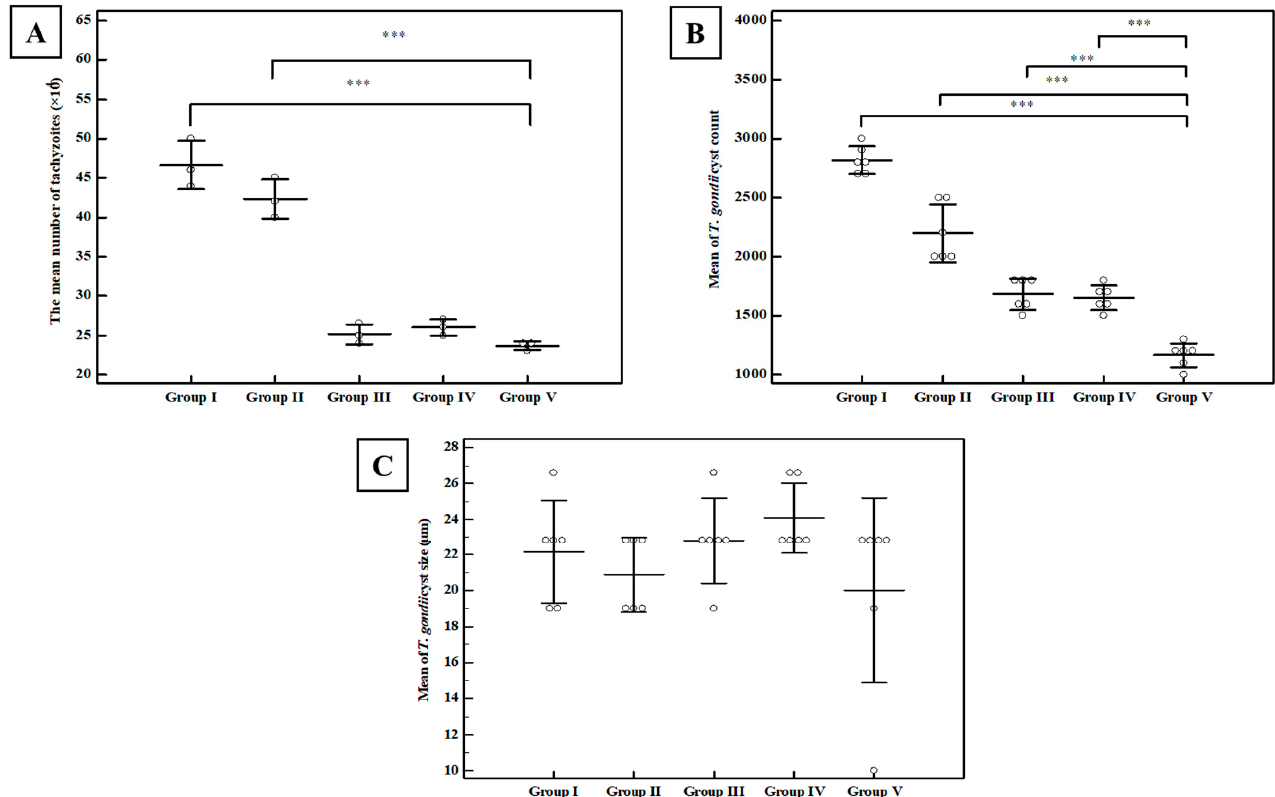
Figure 6. Parasitological study. ( A ) In vitro tachyzoite invasion and replication assay in Vero cells. Tachyzoites of the virulent RH strain were pre-incubated with sera from naïve mice collected on day 0, or with sera collected from mice vaccinated with different studied regimens on day 42 from the beginning of the experiment (i.e., before infection). Dots represent the mean number of T. gondii tachyzoites (×10 4 ) per well in the culture supernatant of Vero cells after incubation. In vitro assays were performed with pooled serum samples ( n = 3) repeated three times. Results represent data from three independent experiments, ( B ) mean of T. gondii cyst count and ( C ) cyst size in brain of mice of different studied groups at week 4 after the in vivo infection challenge with 20 cysts of the avirulent Me49 Toxoplasma strain. Data are expressed as mean ± SD. *** p < 0.001. Group I: Control, Group II: MLT-SLNs, Group III: TLA, Group IV: TLA/ plain SLNs, Group V: TLA/